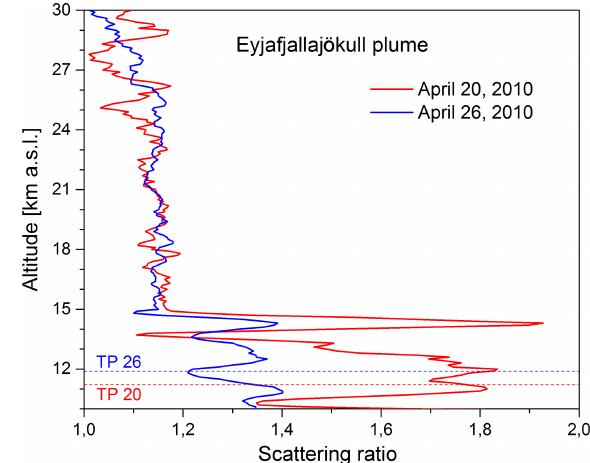
Figure 10. Detection of the Eyjafjallajökull volcanic plumes in the upper troposphere and lower stratosphere over Tomsk. The volcano erupted in Iceland from 14 to 17 April 2010. The tropopause altitude over Tomsk was of 11.2km on 20 April and 11.9km on 26